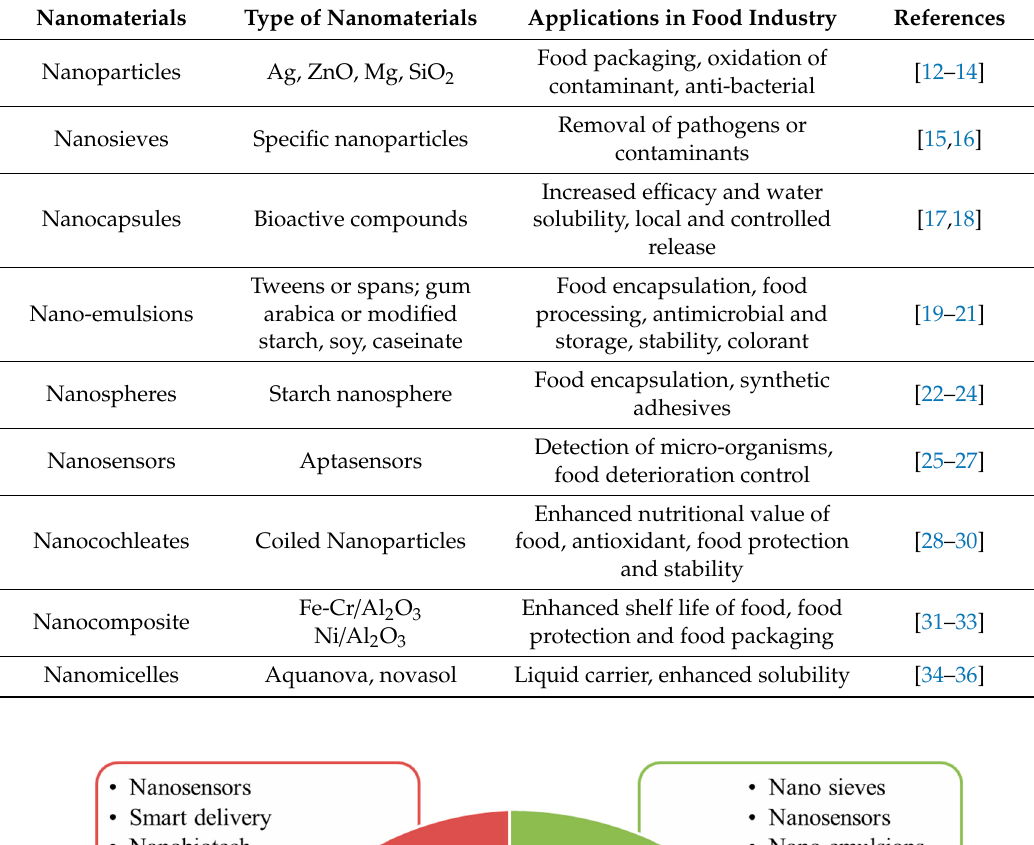
Table 1. An overview of various applications of nanomaterials in the food industry.